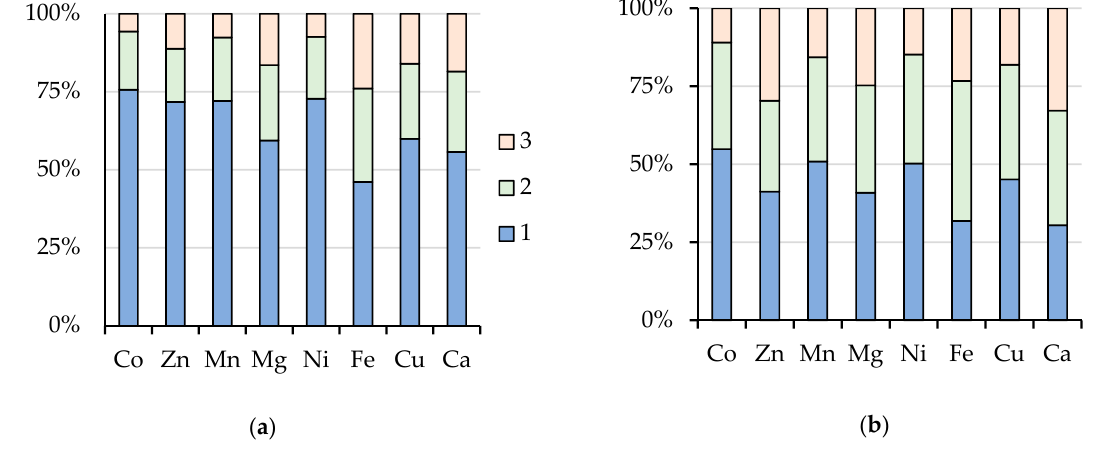
6 of 11 Figure 2. The content of element fractions after sequential treatment with solutions: ( a ) water and AAB; ( b ) 0.1N HNO 3 and the sum of fractions at the ratio of peat to solutions 1 g/50 mL (solid line) and 1 g/25 mL (dash line). Multiple treatments of peat soil markedly increased the total element amounts in the solution